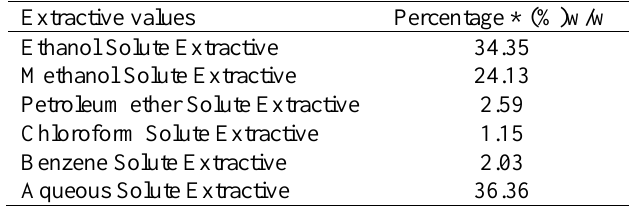
Table 2. Successive solvent extractions of P. sinjiangensis K. Y. Pan.